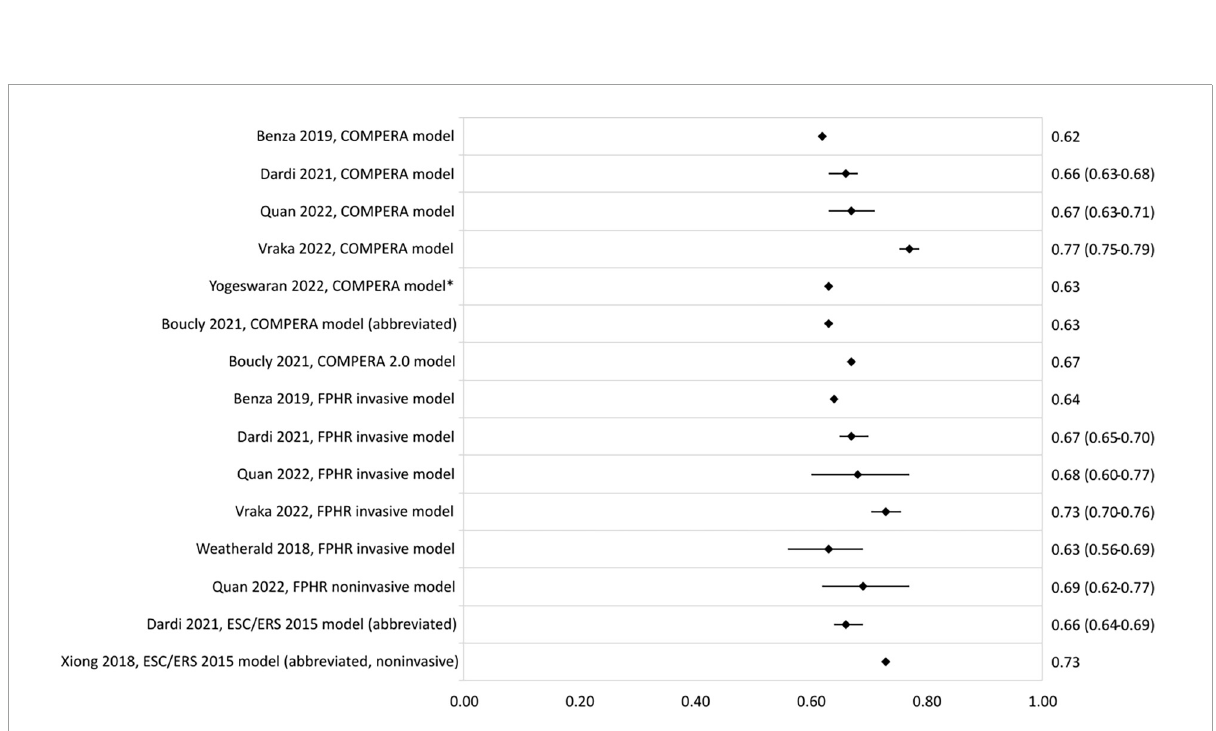
FIGURE3 C-statistic (95% CI) of the development and validation of ESC/ERS 2015 guideline-based models. ∗ Cohort includes PAH and chronic thromboembolic PH